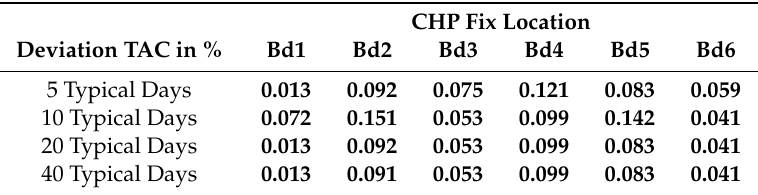
Table 4. Impact of di ff erent fix CHP locations on the TAC.